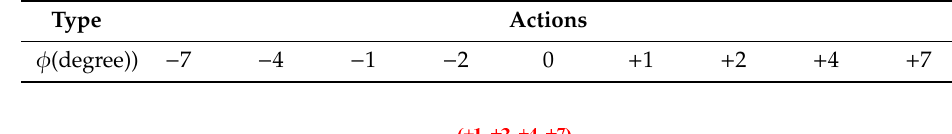
Table 5. Actions of the Q-learning algorithm.